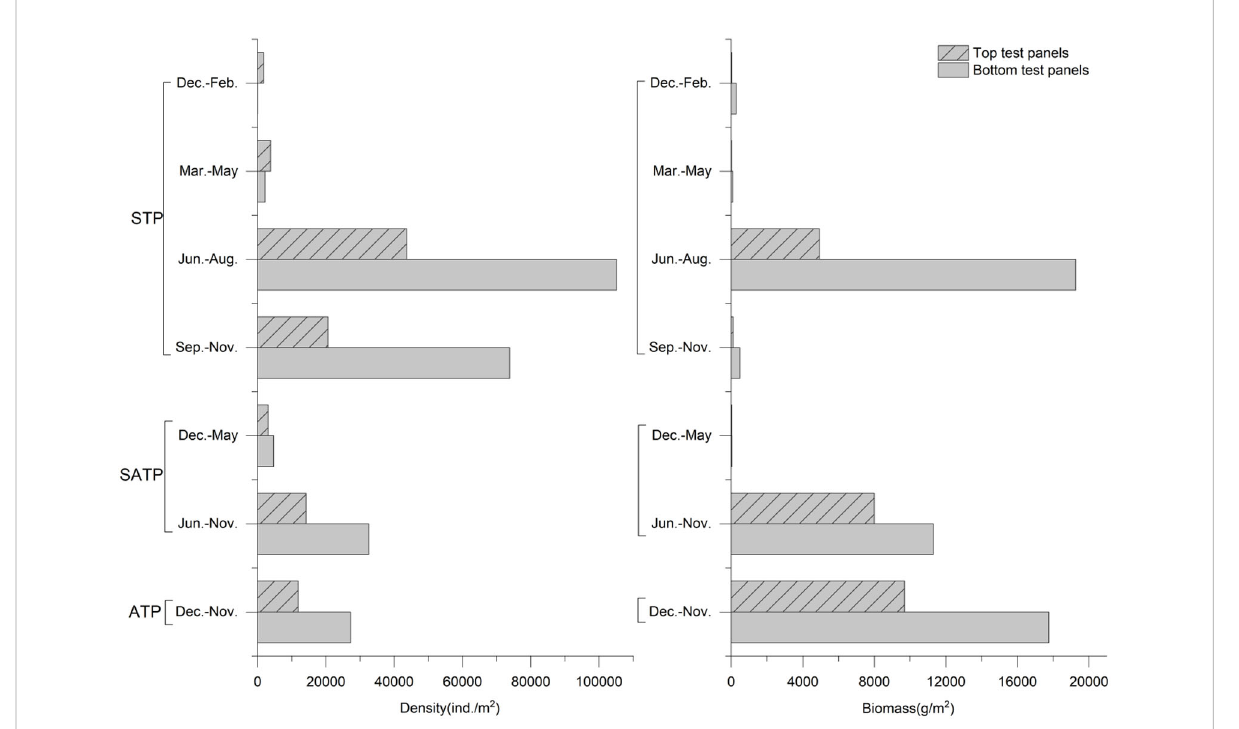
FIGURE 9 The attachment density and biomass of STPs, SATPs and ATPs.